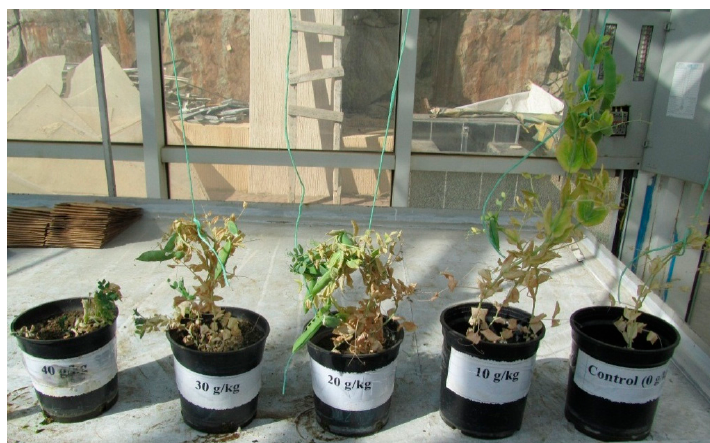
Figure 1. A demonstration of five pots (replicates) represents the Pisum sativum plants grown in sewage sludge-soil with amendment rates of 0 (control), 10, 20, 30 and 40 g/kg.